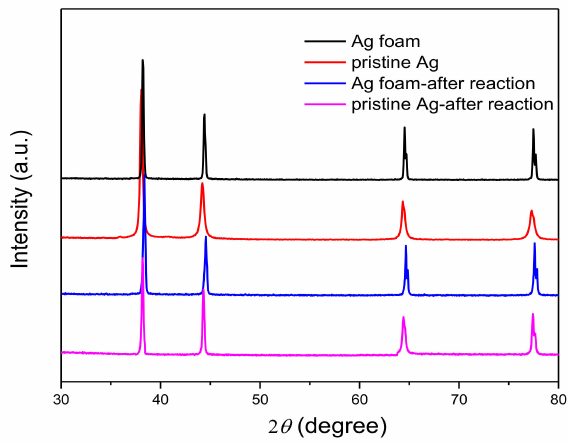
Figure 1. XRD patterns of pristine Ag and Ag foam.